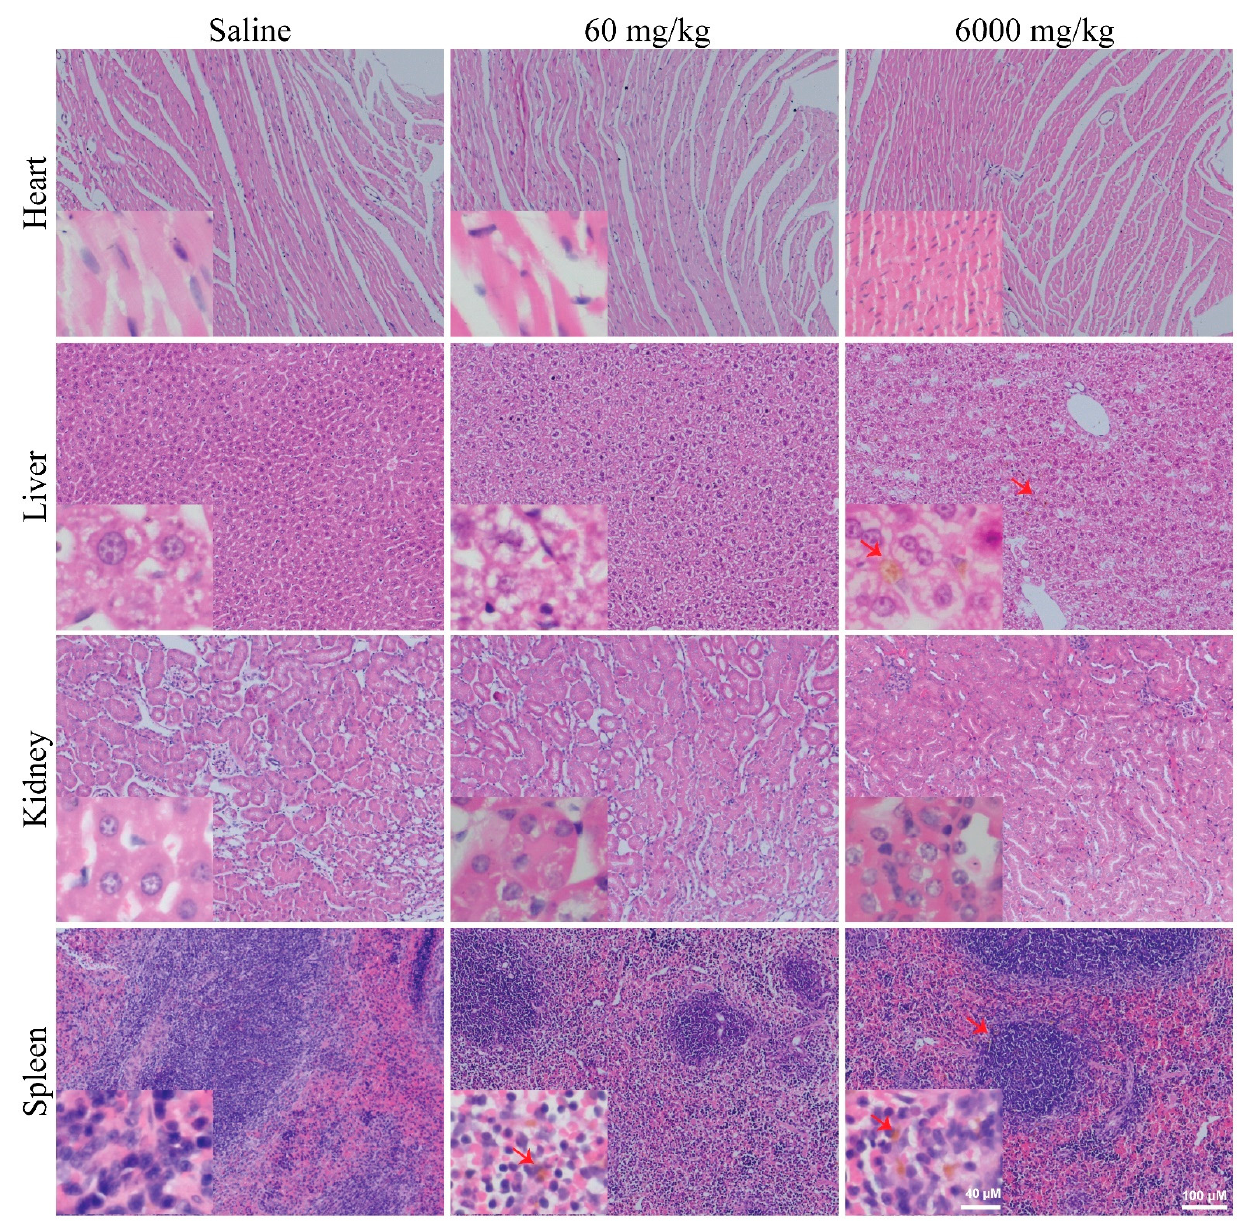
Figure 6. Histopathology of mice organs receiving a single PPN dosage at the concentration of 60 or 6000 mg PPNs/kg after 14 days post single IV administration. Sparse, small depositions ( ≤ 20 µm) of PPNs were observed in the liver and spleen (red arrow). No major abnormalities in the organ structure were detected for both PPN concentrations. Scale bars represent 40 µm (insets) and 100 µm.